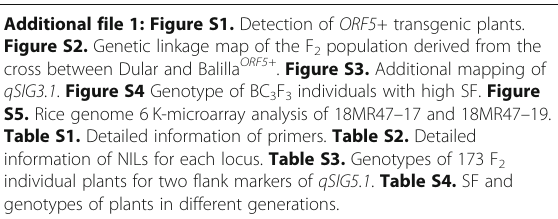
Additional file 1: Figure S1. Detection of ORF5+ transgenic plants. Figure S2. Genetic linkage map of the F 2 population derived from the cross between Dular and Balilla ORF5+ . Figure S3. Additional mapping of qSIG3.1 . Figure S4 Genotype of BC 3 F 3 individuals with high SF. Figure S5. Rice genome 6 K-microarray analysis of 18MR47 – 17 and 18MR47 – 19. Table S1. Detailed information of primers. Table S2. Detailed information of NILs for each locus. Table S3. Genotypes of 173 F 2 individual plants for two flank markers of qSIG5.1 . Table S4. SF and genotypes of plants in different